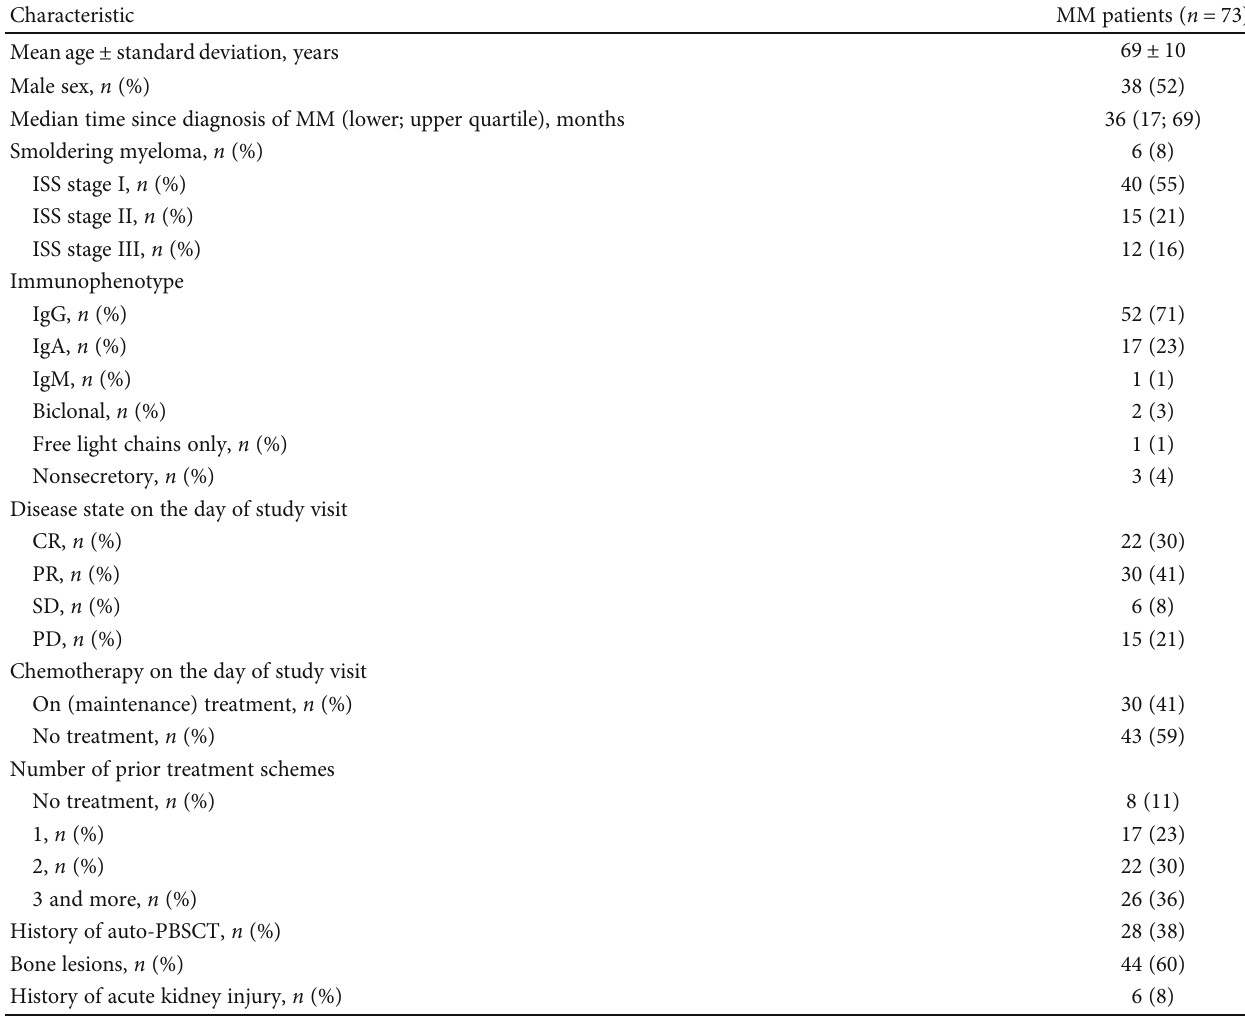
Table 2: Demographic and clinical characteristics of patients at